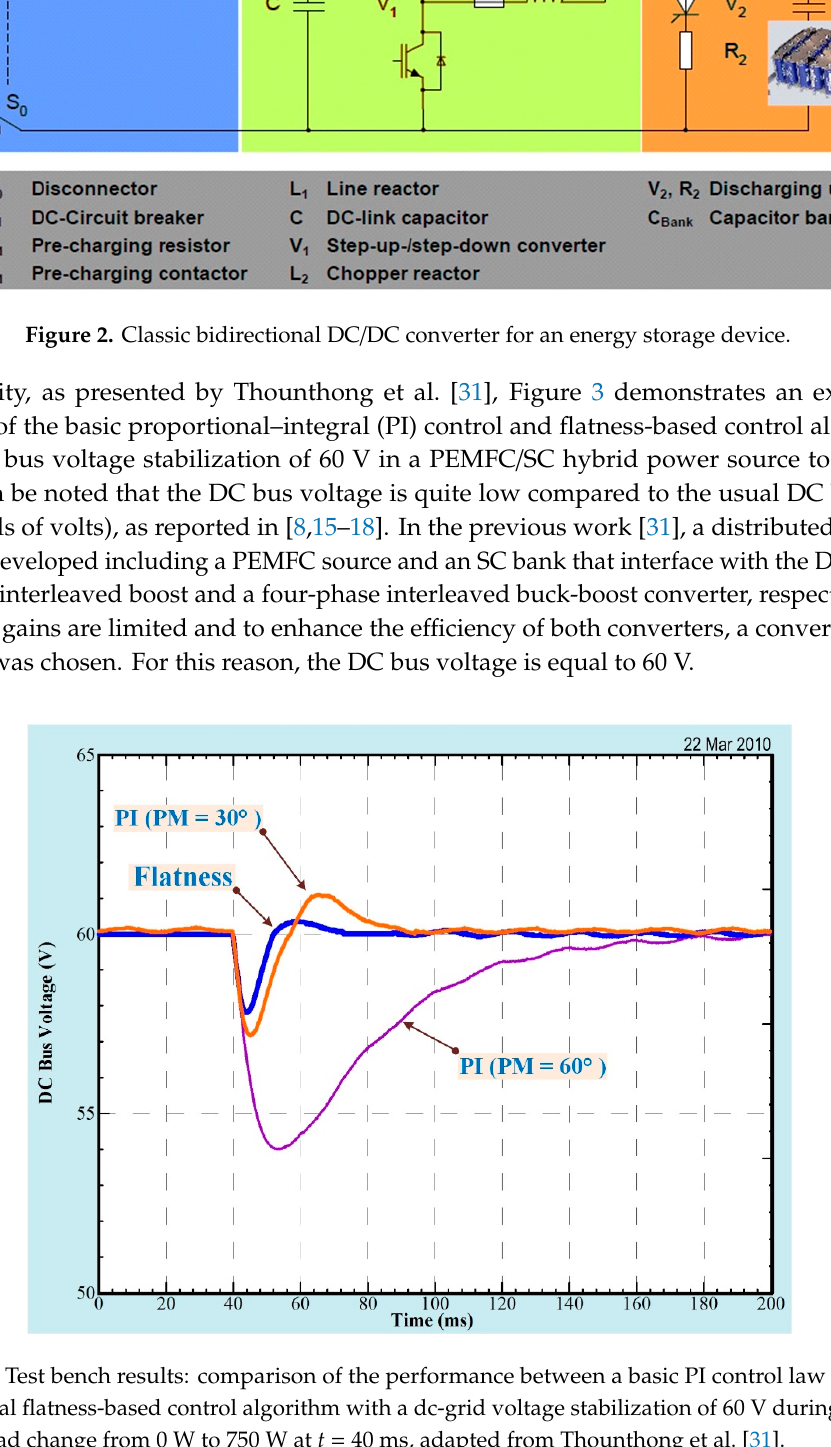
Figure 1. Energy storage network based on a supercapacitor (SC) module in public transportation applications: (a) trolley bus: substation; (b) tramway or train: substation; (c) tramway or train: onboard; and (d) diesel locomotive: onboard.